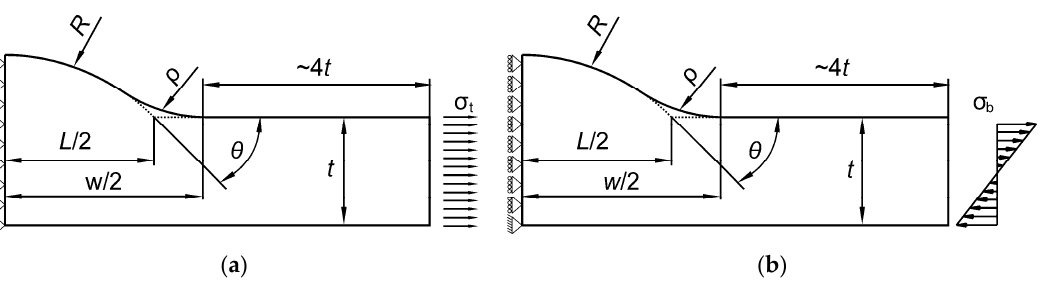
Figure 3. Boundary conditions for a Single–V butt-welded joint subjected to ( a ) tensile and ( b ) bending loads.